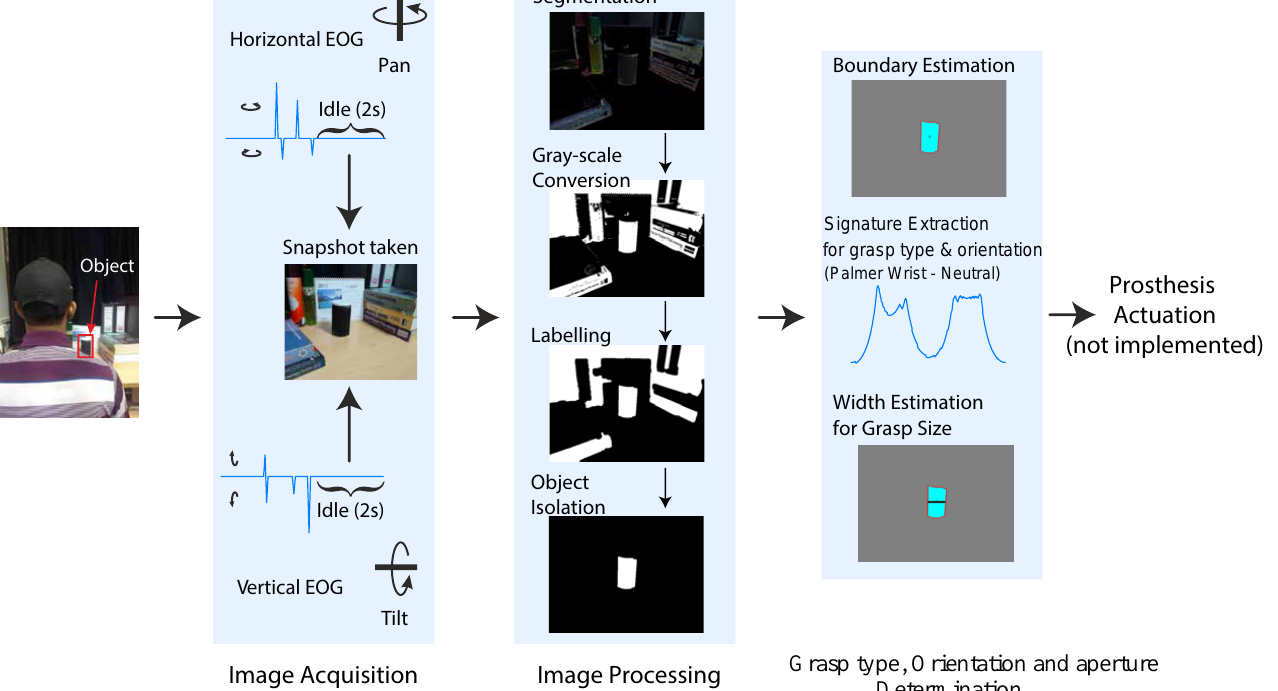
Figure 6. A representative example of correct object detection, signature extraction and width